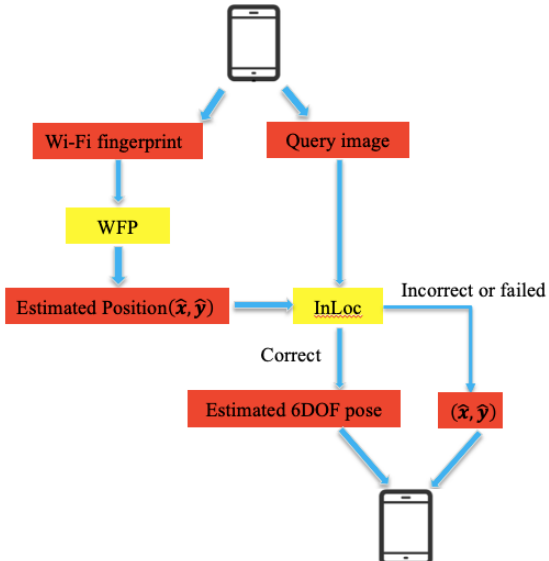
Figure 1. Overview of the proposed system.